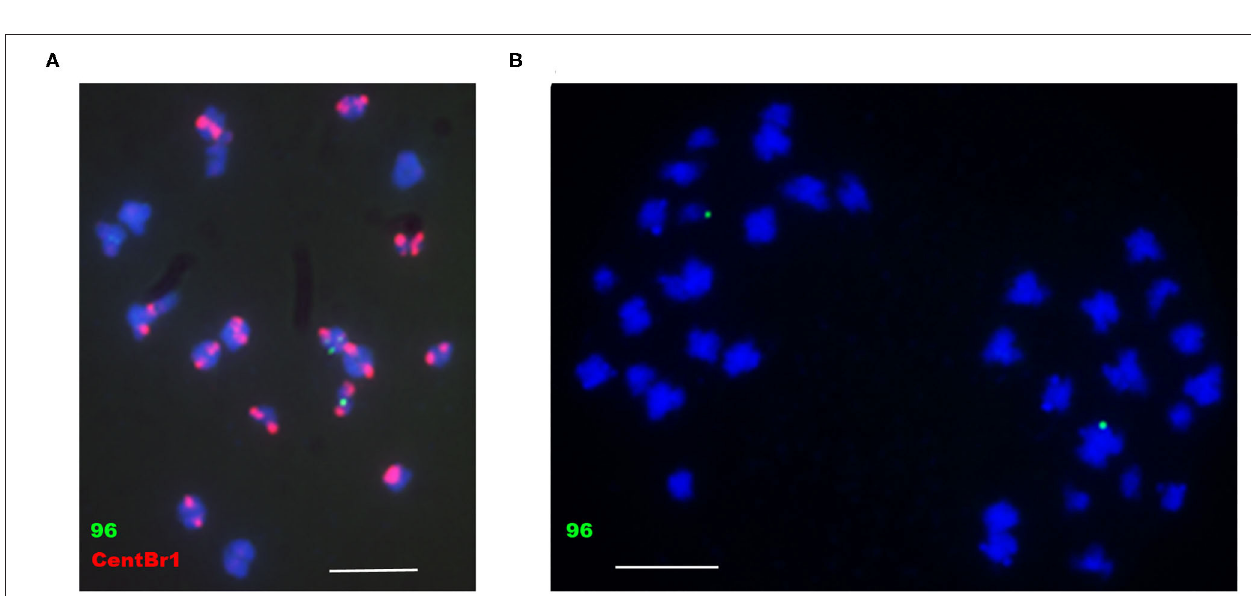
FIGURE 7 | Detection of pollen fertility and activity by FDA-PI. The pollen of 86-1-75-10-74, 86-1-75-10-80, and WT were stained with 3,6-diacetoxyfluoran-propidium iodide (FDA-PI) to detect their fertility and activity. FDA (green) indicates active pollen; PI (red) indicates inactive pollen. The results showed that only ∼ 50% of pollen of transgenic plants containing minichromosomes was active, while the active pollen of WT accounted for more than 90%. Bar = 50 µ m.